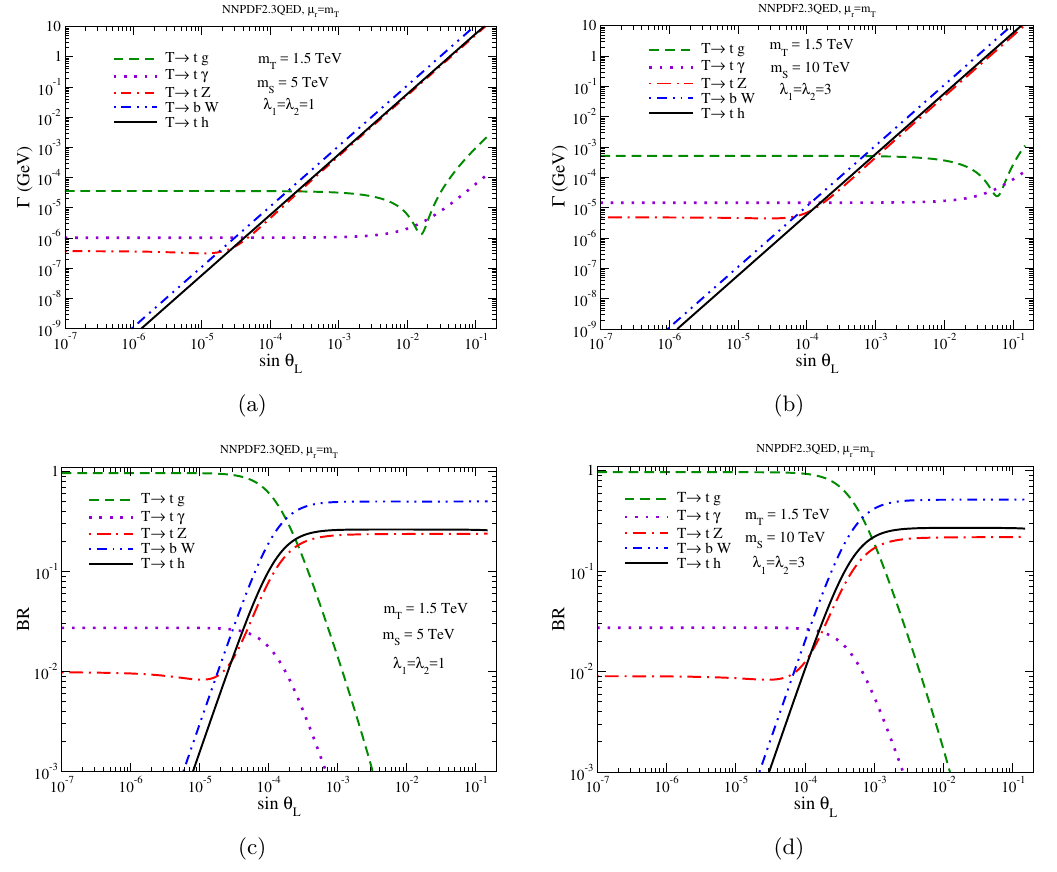
Figure 10 . (a,b) Partial widths and (c,d) branching ratios of the top partner for m S > m T m t (cid:0) for (green dashed) T tg , (violet dotted) T t(cid:13) , (red dash-dot) T tZ , (blue dash-dot-dot) ! ! ! T bW , and (black solid) T th . These are shown for top partner mass m T = 1 : 5 TeV. The ! ! remaining parameters are (a,c) m S = 5 TeV, (cid:21) 1 ; 2 = 1 and (b,d) m S = 10 TeV, (cid:21) 1 ; 2 = 3.